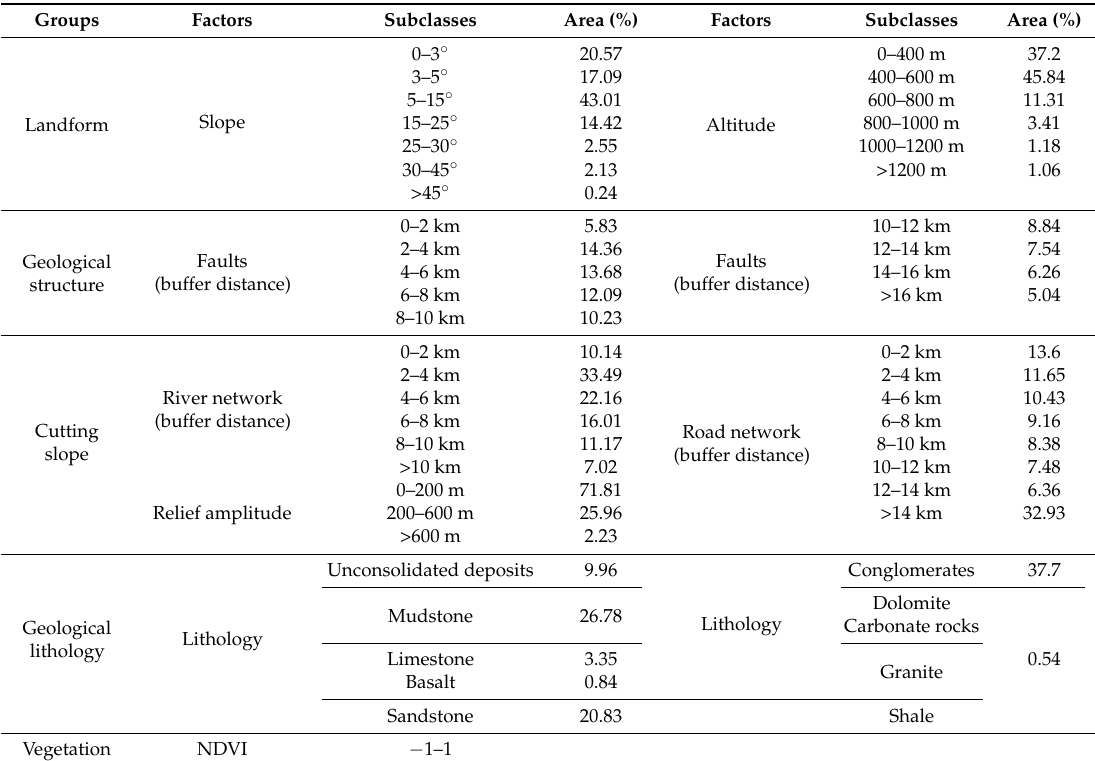
Table 1. Evaluation factor system for landslides in the Sichuan Province